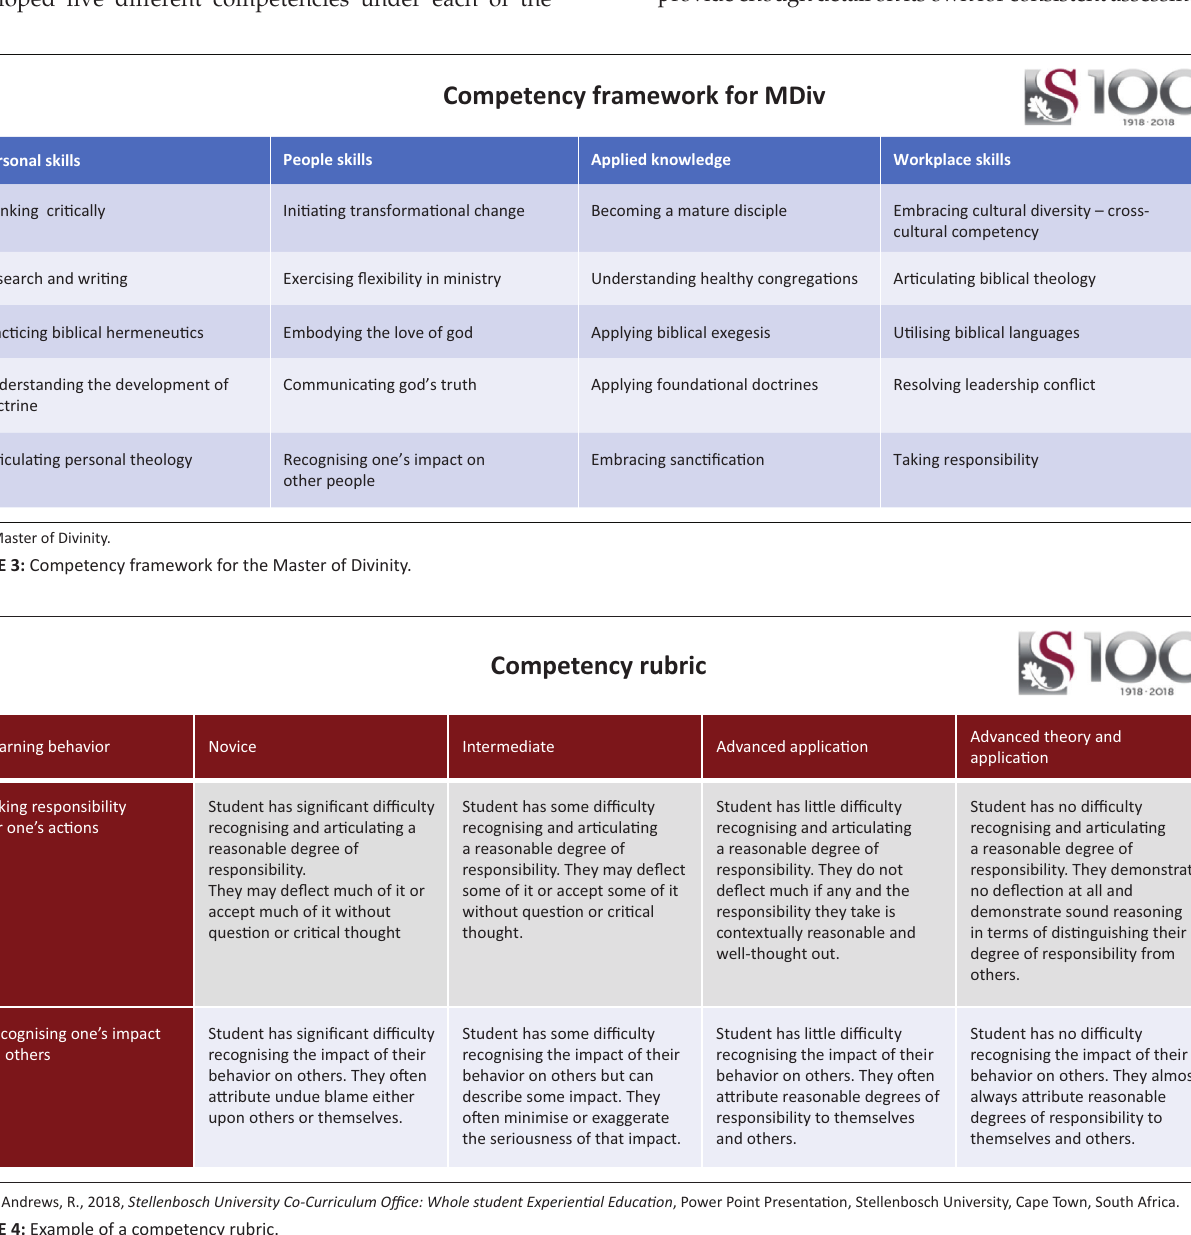
FIGURE 4: Example of a competency